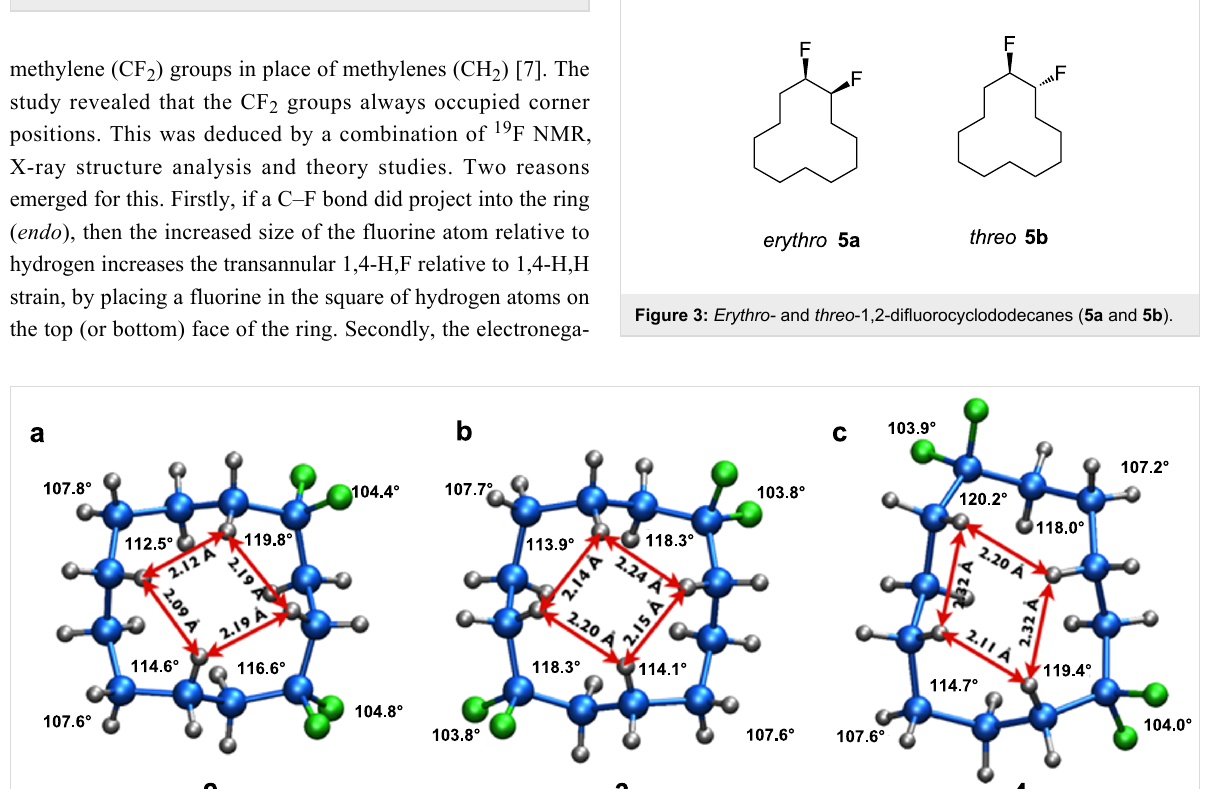
Figure 1: The Dunitz and Shearer structure of cyclododecane ( 1 ) [1,2]. There are four endo hydrogens above and four below the plane of the ring, which are tensioned as they are within van der Waals contact distances. Thus the ring adopts a [3333] square-type structure. (Reproduced with permission from [1]; Copyright © 1960 Verlag GmbH & Co KGaA, Weinheim).